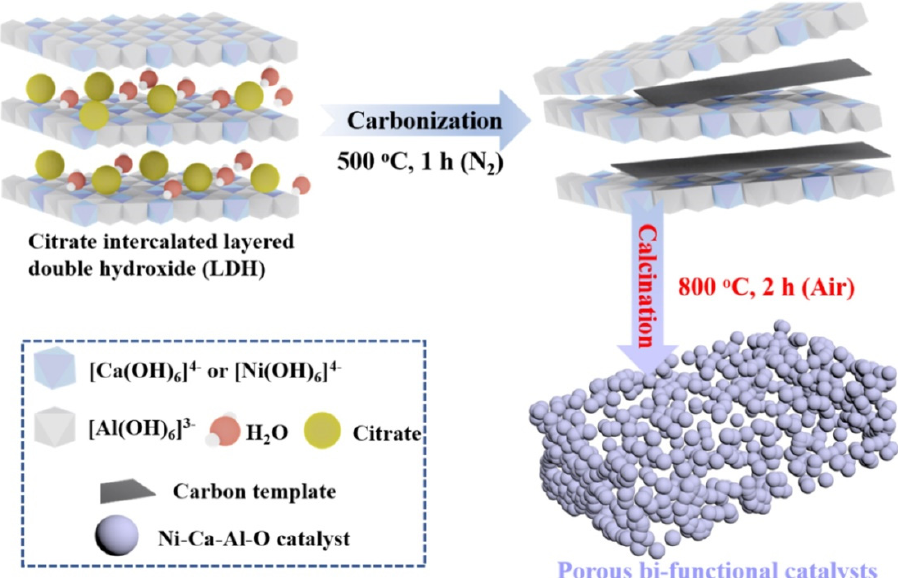
Figure 4. A new catalyst synthesis method for preparing a bifunctional catalyst used in the SESR reaction [74]. Copyright 2021, Elsevier.